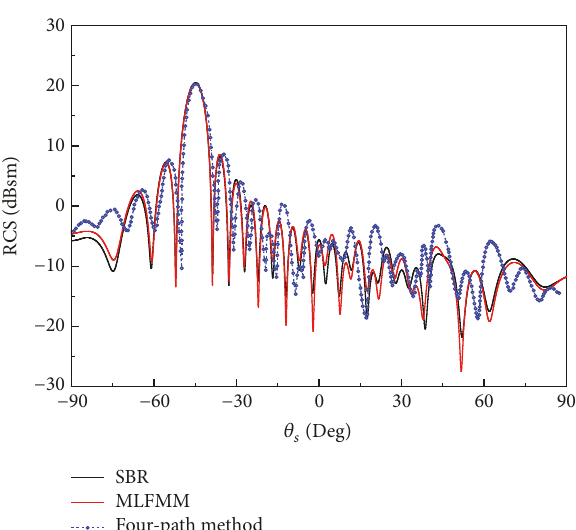
Figure 9: Bistatic RCS results for 0.03 m cube on flat plate.